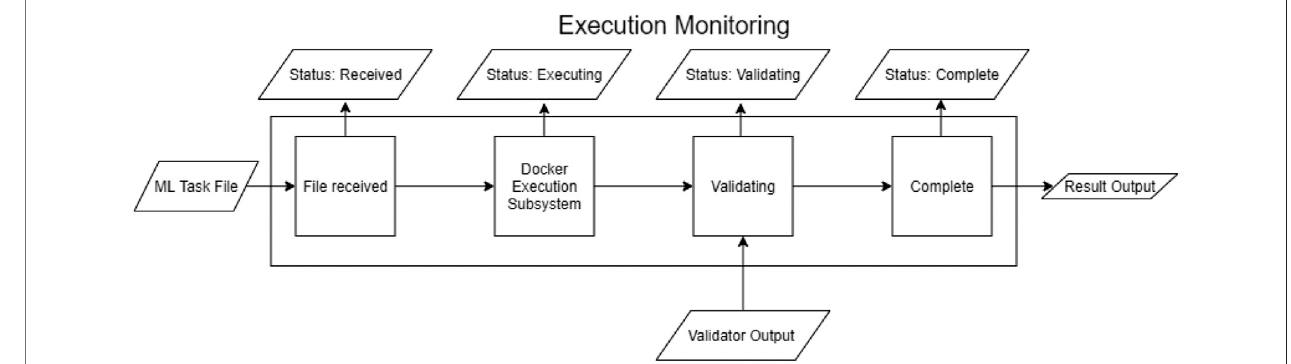
FIGURE 4 | Simpli fi ed execution status